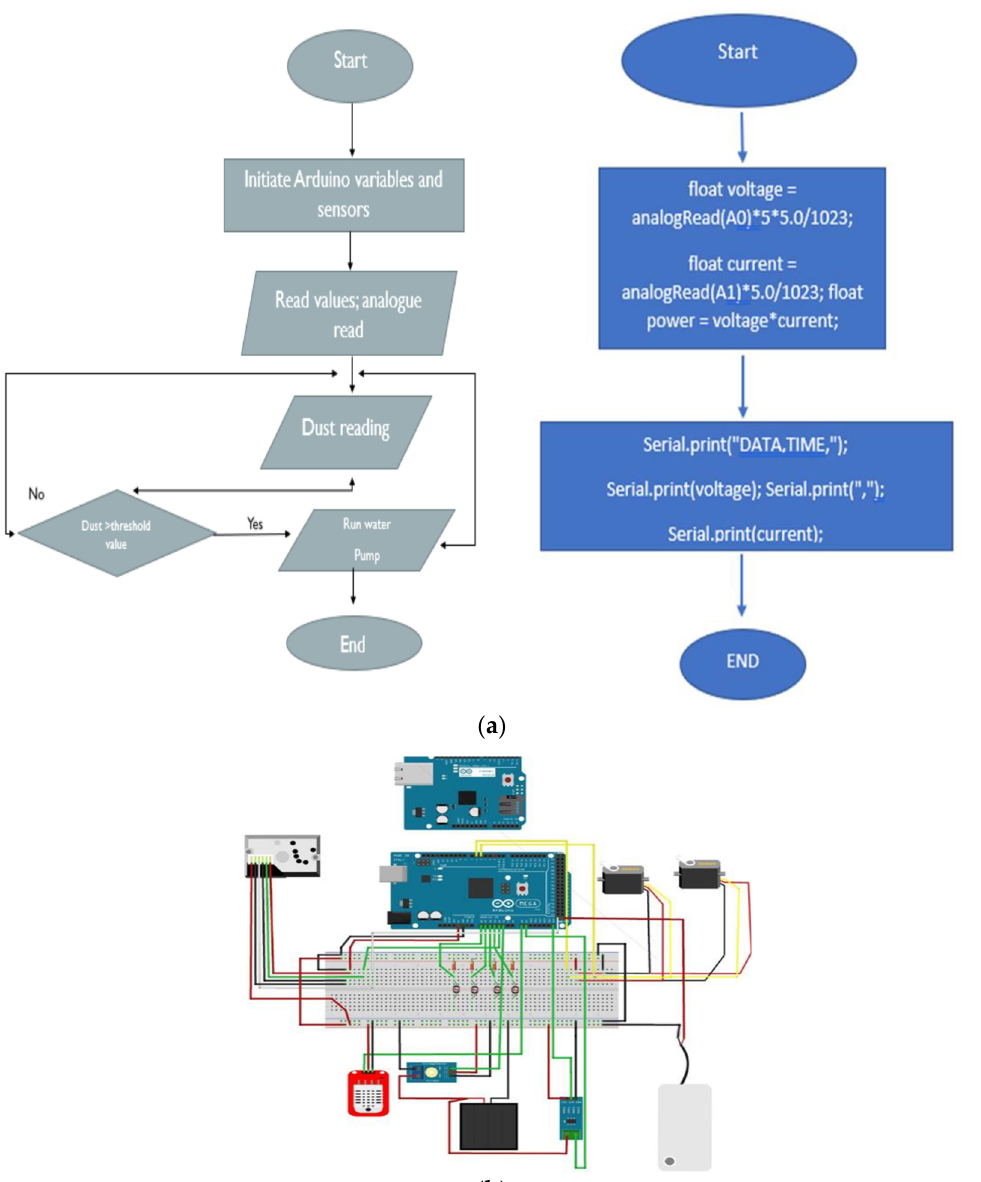
Figure 1. Schematic view of solar tracking system.